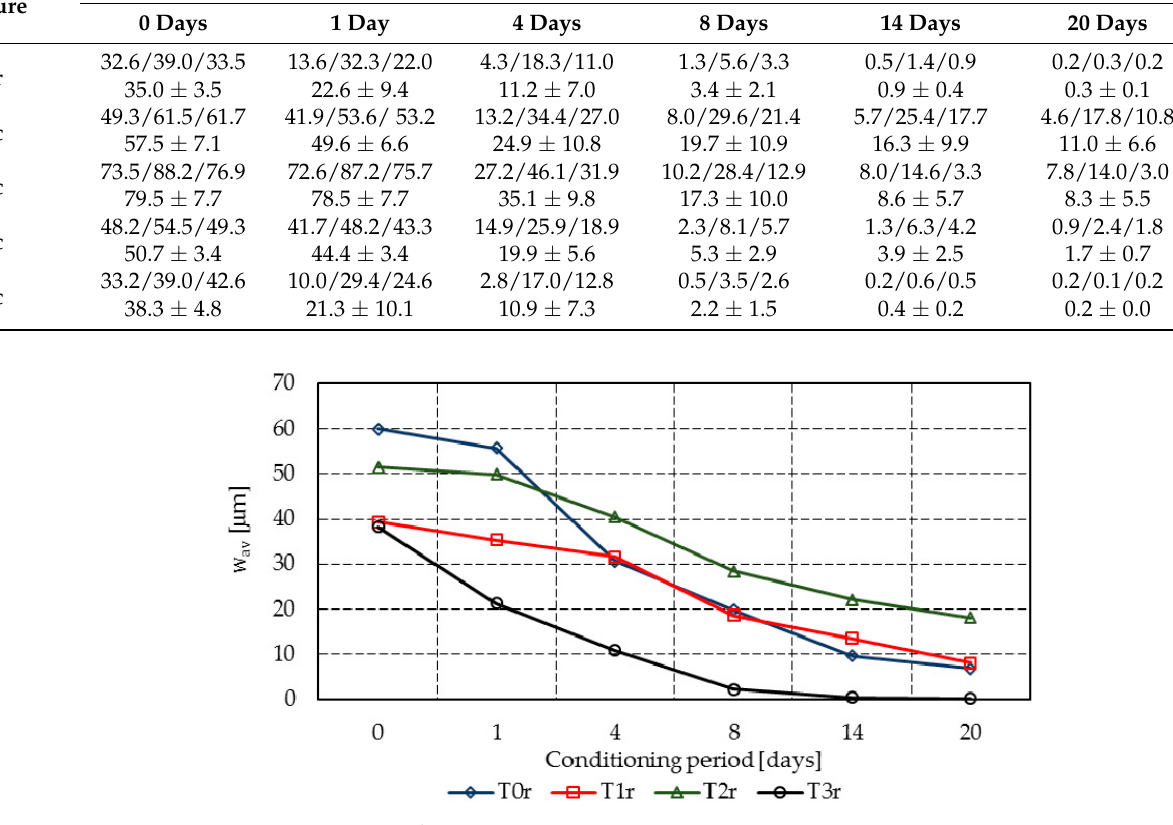
( b ) Figure 6. Initial crack and self-sealing products at 20 days of the reference mixes: ( a ) T0r; ( b ) T0c.